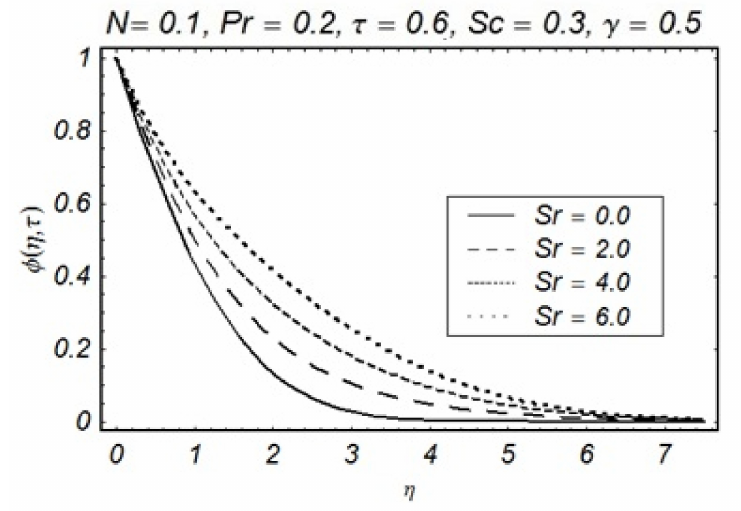
Figure 15. Indication of Sr on solute profile.